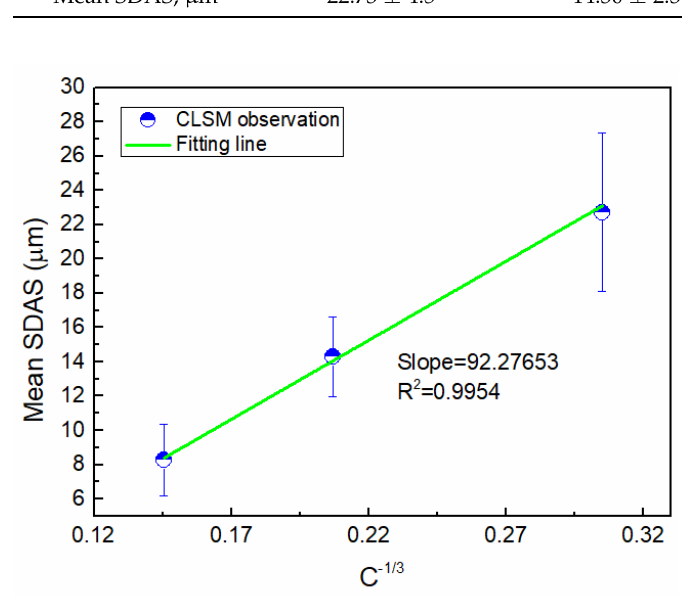
Figure 12. The result of linear regression.